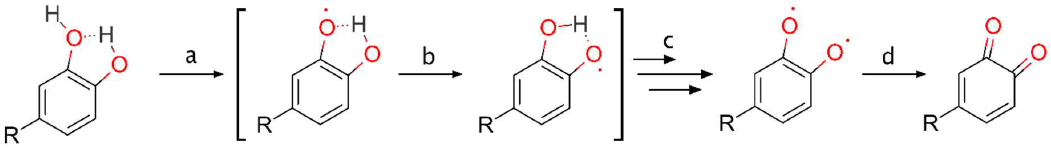
Figure 4. Example of catechol moiety hydrogen swap reaction and reorganization mechanism for